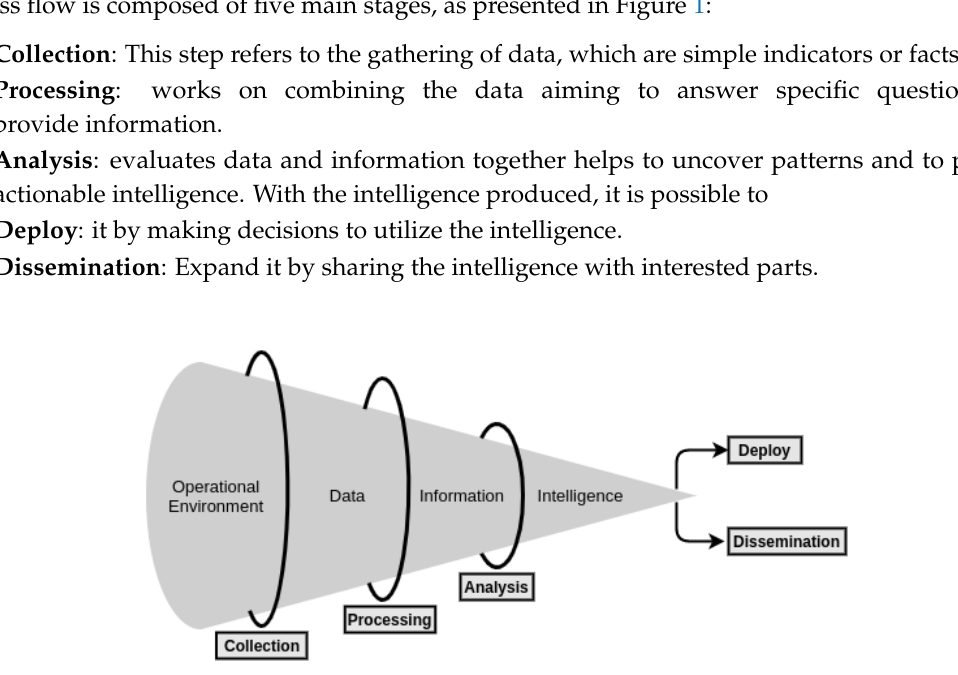
Figure 1. Threat Intelligence Production Process